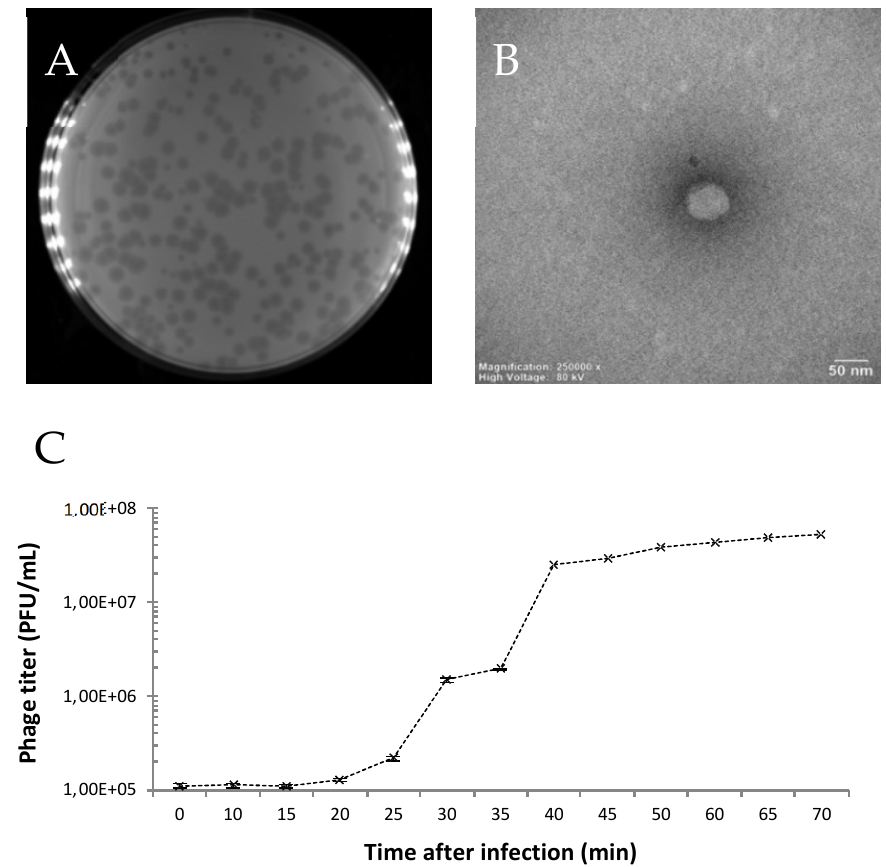
Figure 1. Morphology and one-step growth curve of SoKa. ( A ) Macroscopic view of the SoKa plaques on a bacterial lawn shows clear lysis plaques with a diameter of 0.5–2 mm. ( B ) TEM micrograph of SoKa displays a podovirus morphology with a head diameter of 60 nm. Bar represents 50 nm. ( C ) One-step growth curve of SoKa on the Pseudomonas syringae pv. syringae strain KB49 at different time points. Each data point is a mean from three experiments. The error bars show the standard error of the mean.